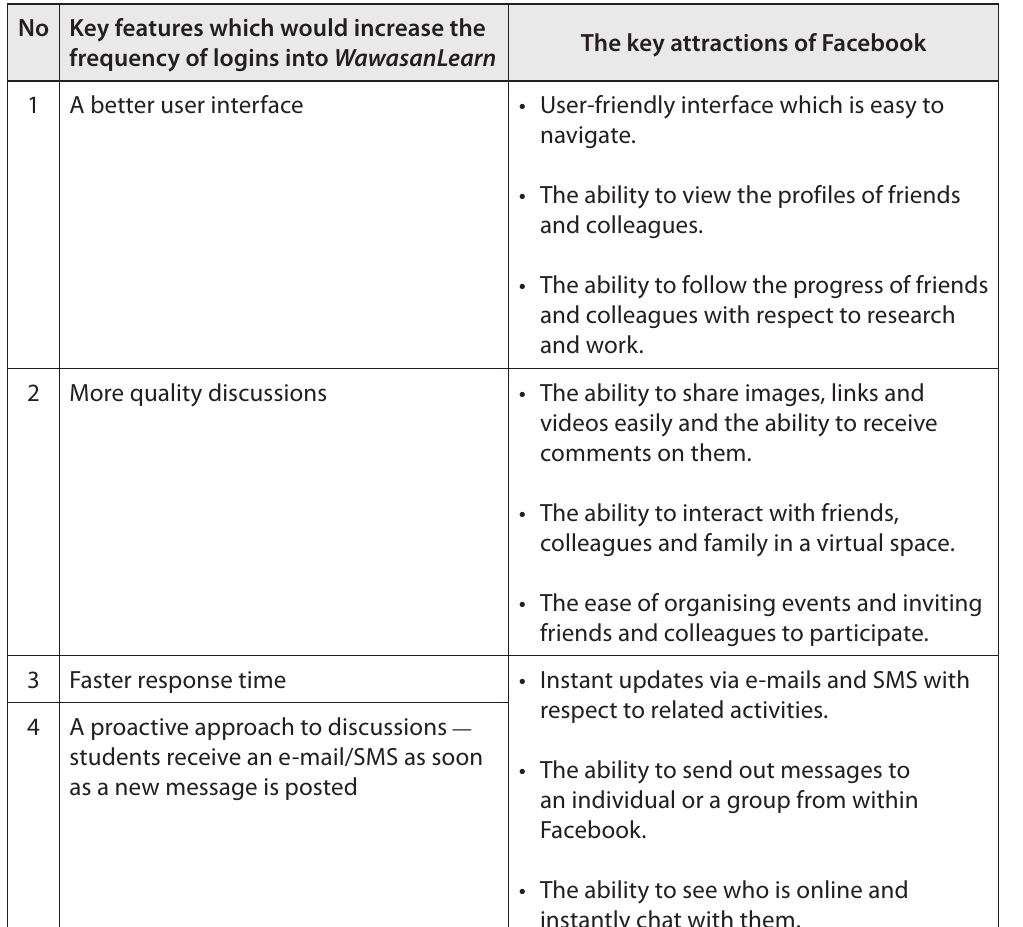
Table 2 Mapping of the required features of WawasanLearn to the key attractions of Facebook